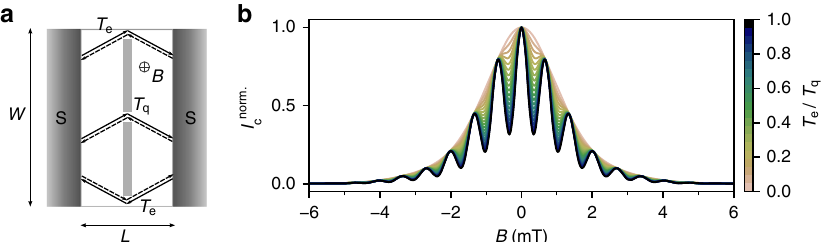
Fig. 6 Effect of the edge currents on the interferometric pattern. a Schematic of the superconducting weak link with a quantum point contact like geometry including possibility of edge currents used for our analytical model. b Calculated I norm : = T coef fi cient ratio T e